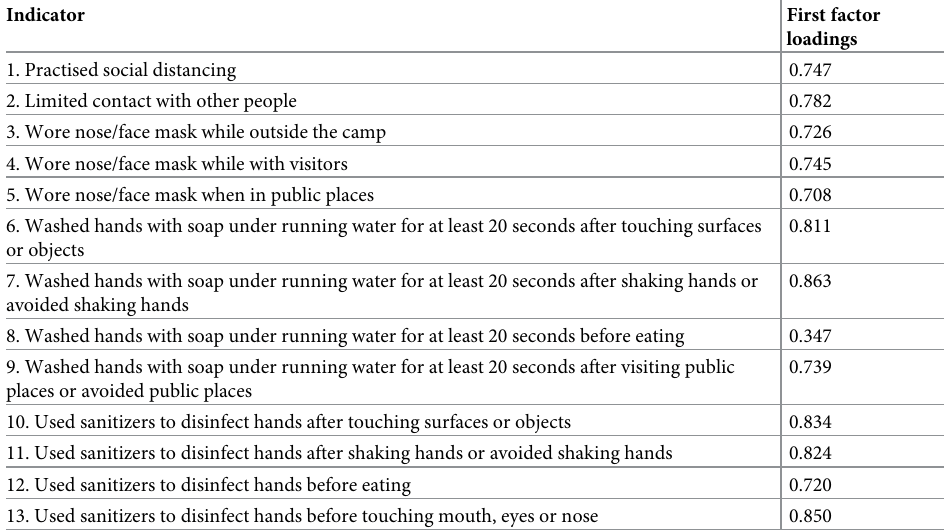
Table 3. Indicators used to measure adherence to the COVID-19 preventive measures.